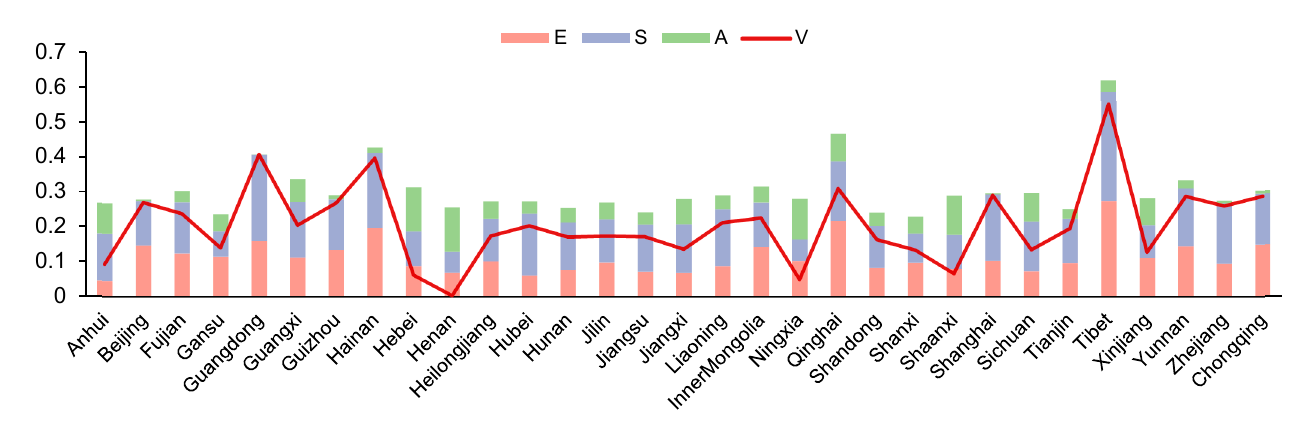
Figure 5. Provincial assessment results of the population health vulnerability for the six types of chronic diseases in 2020. The di ff erent colors of the bar stack plot represent the exposure score (E), sensitivity score (S) and adaptability score (A), respectively. The red line indicates the vulnerability assessment score V. Since V = E + S − A, the points of the line do not overlap with the top of the bar chart but have a distance of value from the top.